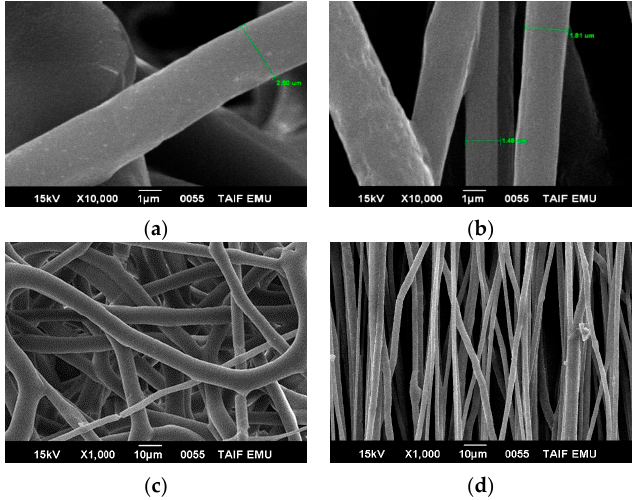
Figure 2. The samples of pure PHB at different scales were collected on the aluminum foil with the following polymer concentrations, die diameter, applied voltages, CF/DMF ratios, flow rate, and distance between the needle and target: 20 wt. %, 1.3 mm, 20 kV, 90:10, 0.185 µm ⋅ h − 1 , and 20 cm, respectively. ( a , c ) at a fixed target (random) with different scales, and ( b , d ) at a rotating drum with a speed of 1100 rpm.